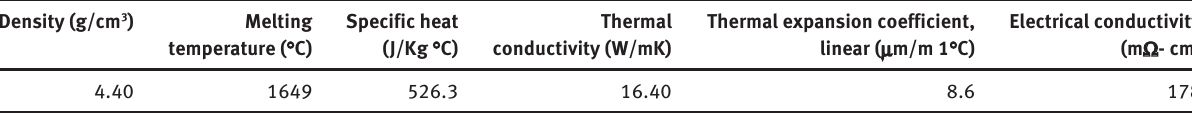
Table 1 Ti-6Al-4V physical